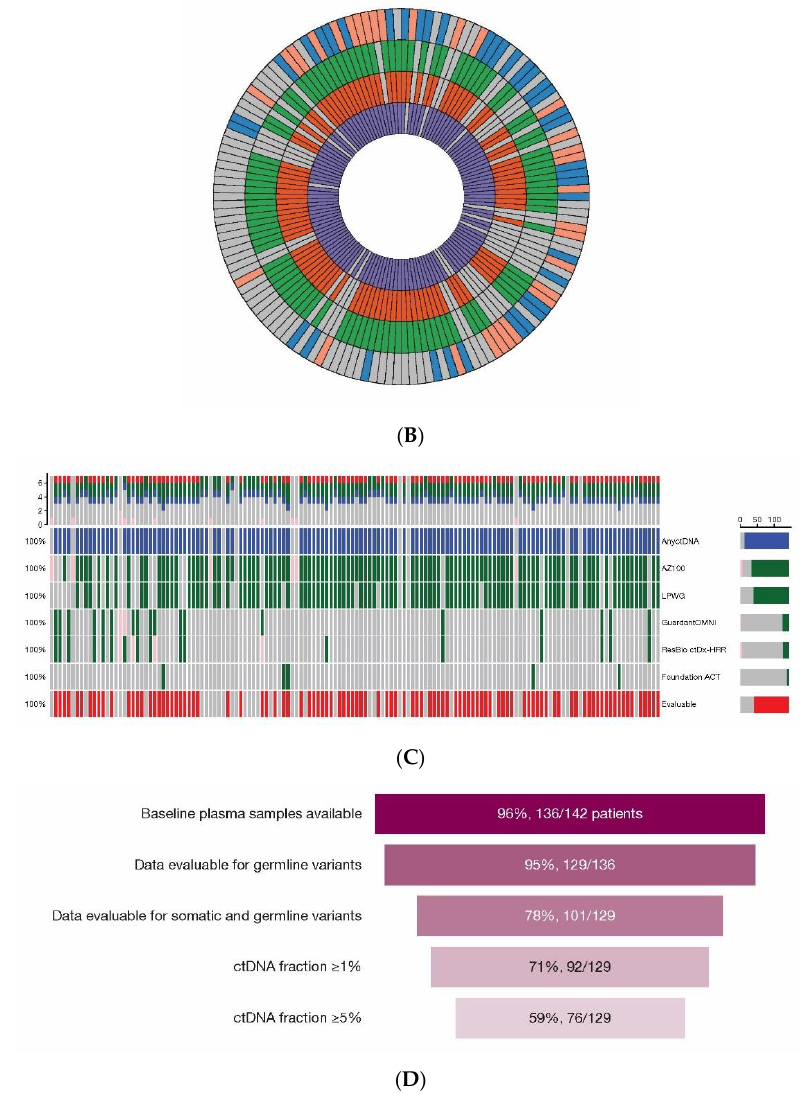
Figure 1. Summary of samples analysed. Illustration of the HRRm assays performed across tumour, germline and plasma (ctDNA) samples from patients in ( A ) initial and ( B ) final analyses for this study. Each segment represents a patient, and each tile within the segments represents the result from the relevant test. From the outer edge moving inwards, blue— tissue (FoundationOne), green—germline blood (Color Genomics), orange—germline blood (HLI WGS), purple—any ctDNA (plasma) assay. Pink/salmon indicates a failed test. Gray indicates no sample available or not assayed at that point. ( C ) Plasma assay results from the final analysis separated by specific assay. Patients were considered tumour shedders (“evaluable”) if there was high confidence detection of at least one somatic variant at or above 1% VAF not attributed to clonal haematopoiesis. ( D ) Outcomes of plasma sample analyses. Somatic alterations attributed to tumour or a clear signal of ctDNA were identified in 78% (101/129) of samples with a plasma test result. Of these 129 patients, analysis of ctDNA identified 76 (59%) with a tumour fraction ≥ 5%, 16 (12%) with a tumour fraction of 1–5%, and 9 (7%) had detectable tumour fraction at <1%. (ctDNA, circulating tumour DNA; HLI, Human Longevity Inc.; HRR, homologous recombination repair; HRRm, homologous recombination repair mutation; LPWG, low-pass whole genome; VAF, variant allele frequency; WGS, whole genome